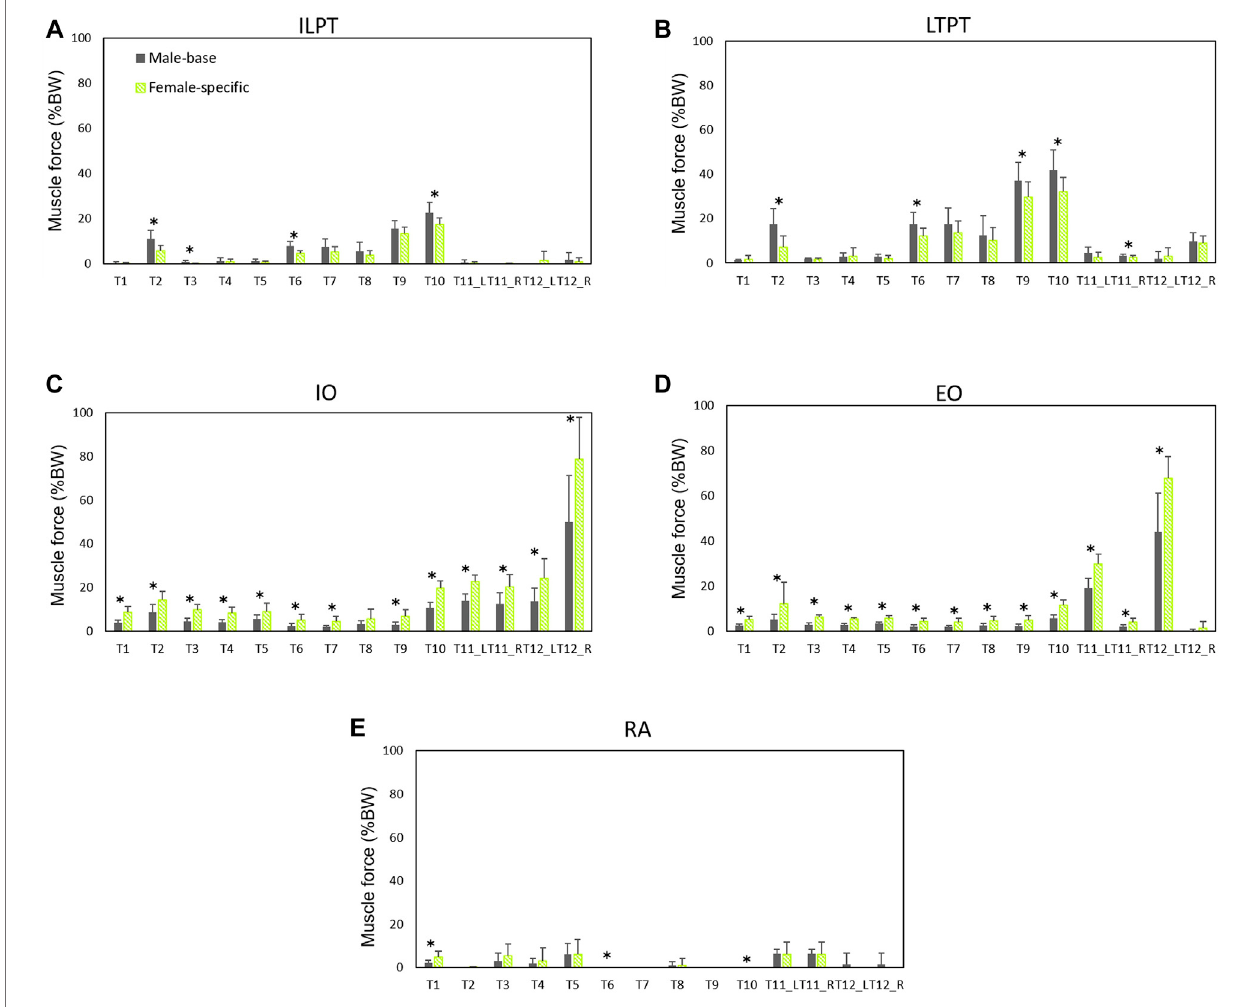
FIGURE 5 | Global muscle forces (average of left and right) as predicted by males ’ models and female-speci fi c models: (A) iliocostalis lumborum pars thoracic (ILPT), (B) longissimus thoracis pars thoracic (LTPT), (C) internal oblique (IO), (D) external oblique (EO), and (E) rectus abdominis (RA). * indicates asigni fi cant difference ( p < 0.05) between males and